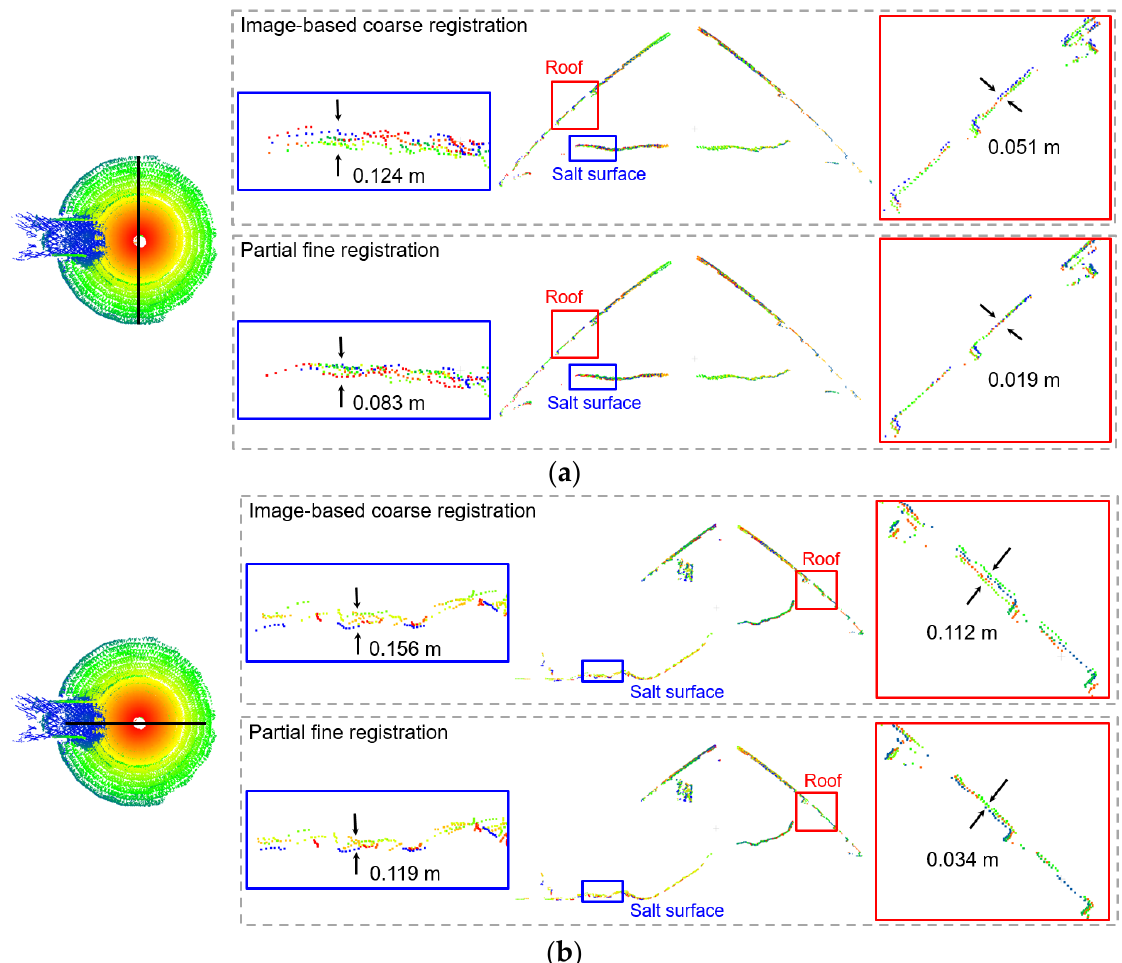
Figure 28. Extracted vertical profiles (width: 0.2 m) for the Lebanon dataset before/after partial fine registration (the arrows indicate the direction of the measured distance): ( a ) profile orthogonal to the entrance walls and ( b ) profile parallel to the entrance walls.